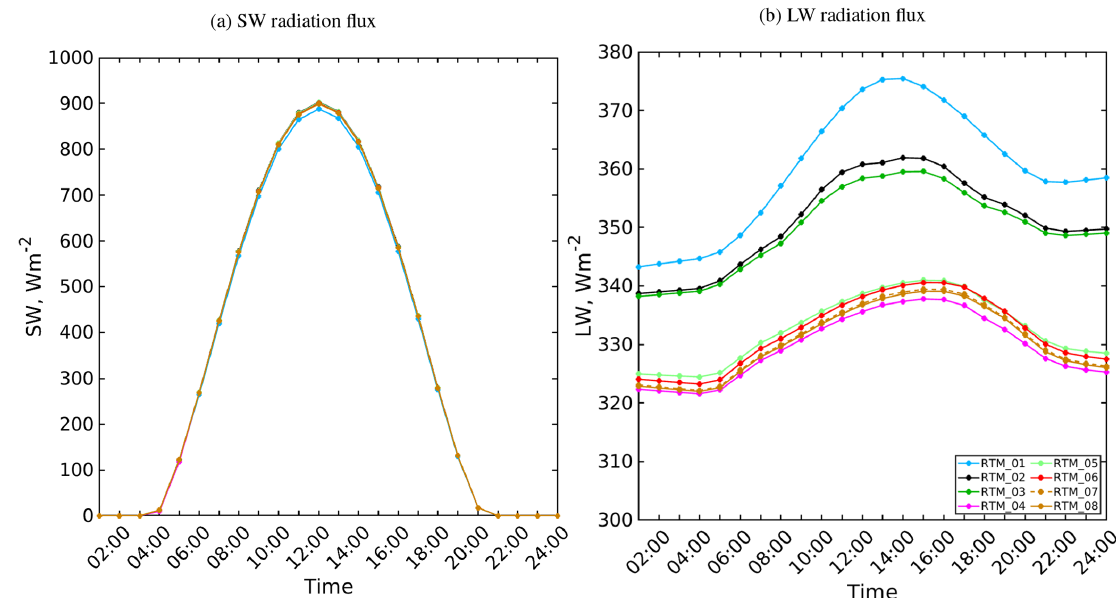
Figure 3. The daily course of incoming (a) shortwave and (b) longwave radiation fluxes for the top of the urban layer of the simple urban configuration at 52 ◦ N on 1 July for different RTM configurations. Please note that the lines overlap in panel (a) due to the small relative changes in the incoming SW radiation.